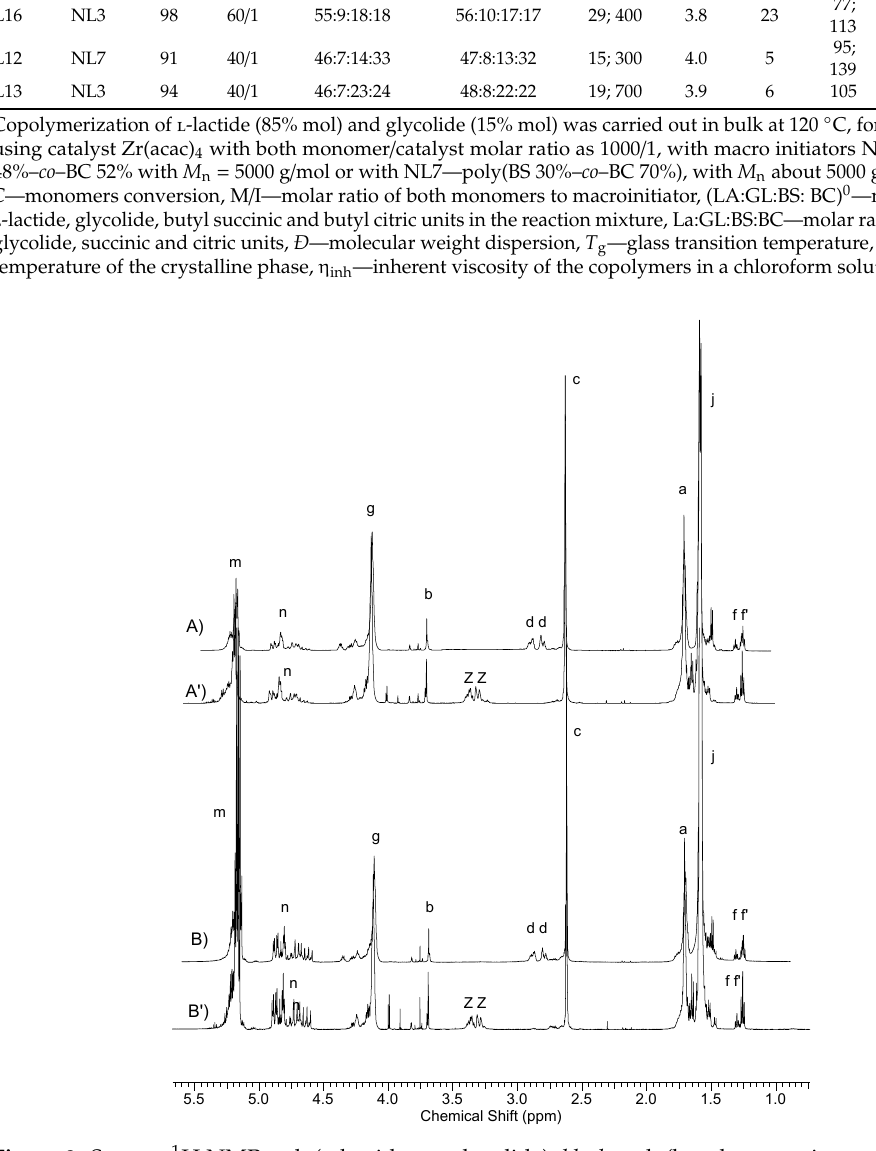
Figure 8. Spectra 1 H NMR poly( L -lactide– co –glycolide)– block –poly(butylene succinate– co –butylene citrate); ( A ) sample NL13, ( A’ ) sample NL13 after reaction with trichloroacetyl isocyanate, ( B ) sample NL14 and ( B’ ) sample NL14 after reaction with trichloroacetyl isocyanate.